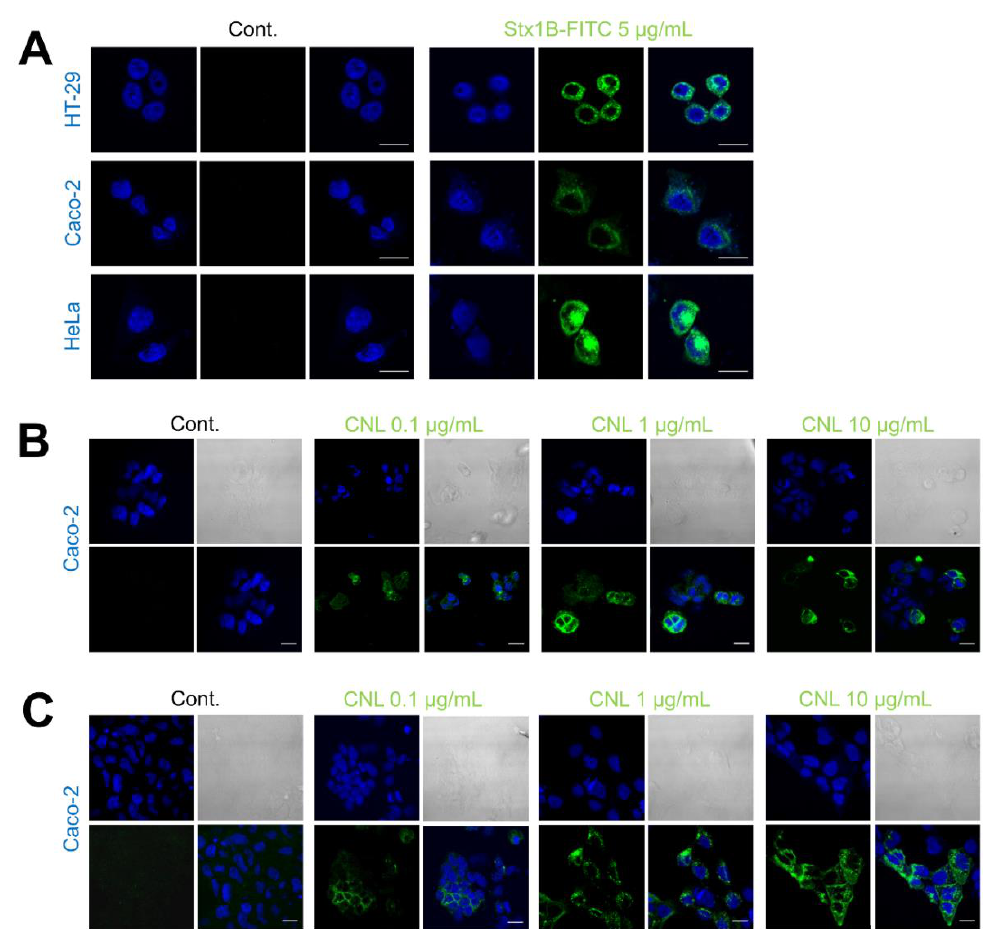
Figure 2. Representative confocal microscopy images showing the binding of FITC-labelled Shiga holotoxin subunit B (Stx1B-FITC; 5 µg/mL) to HT-29, Caco-2, and HeLa cells after 1 h ( A ) and the binding of Clitocybe nebularis lectin (CNL; 0.1, 1, or 10 µg/mL), detected by immunostaining, to Caco-2 cells after 1 h ( B ) and 48 h ( C ). ( A ) DAPI (blue; left panel), Stx1B-FITC (green; middle panel), and merged images (right panel). ( B ) DAPI (upper left panel), bright field (upper right panel), CNL detected with rabbit anti-CNL antibody in combination with anti-rabbit Alexa Fluor 555-conjugated antibody (green; lower left panel), and merged images (lower right panel). Scale bars: 20 µm.